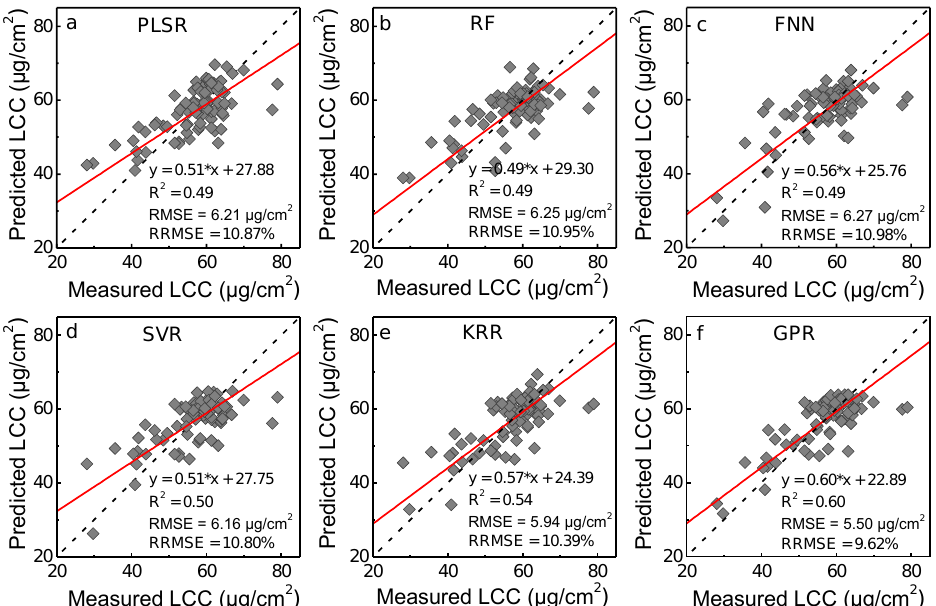
Figure 4. Cross-validation results of different MLRAs for LCC estimation. ( a ) – ( f ) are results for PLSR, RF, FNN, SVR, KRR, and GPR, respectively.